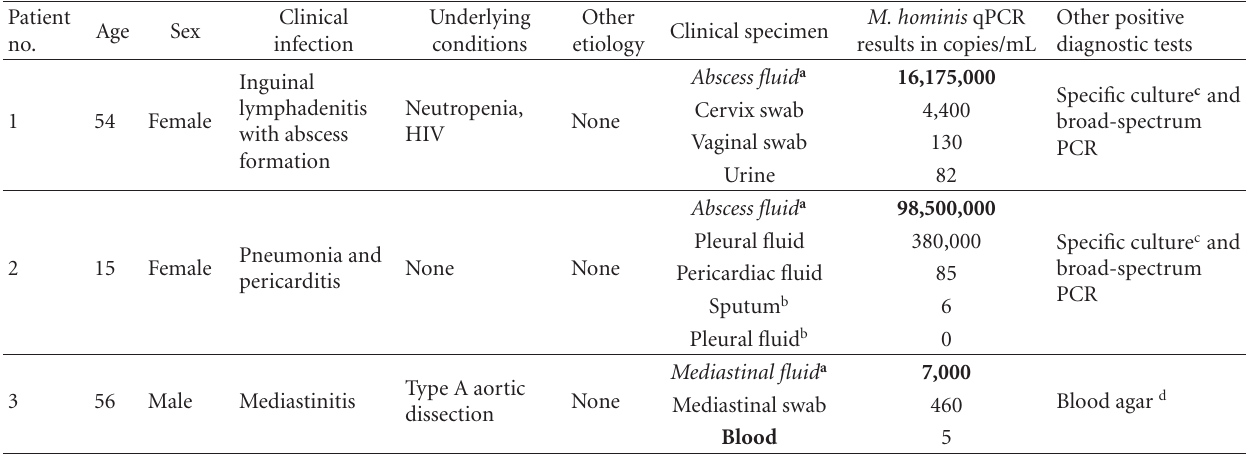
Table 1: Characteristics of three patients with Mycoplasma hominis extra-genital infections, including clinical presentation and results of the real-time